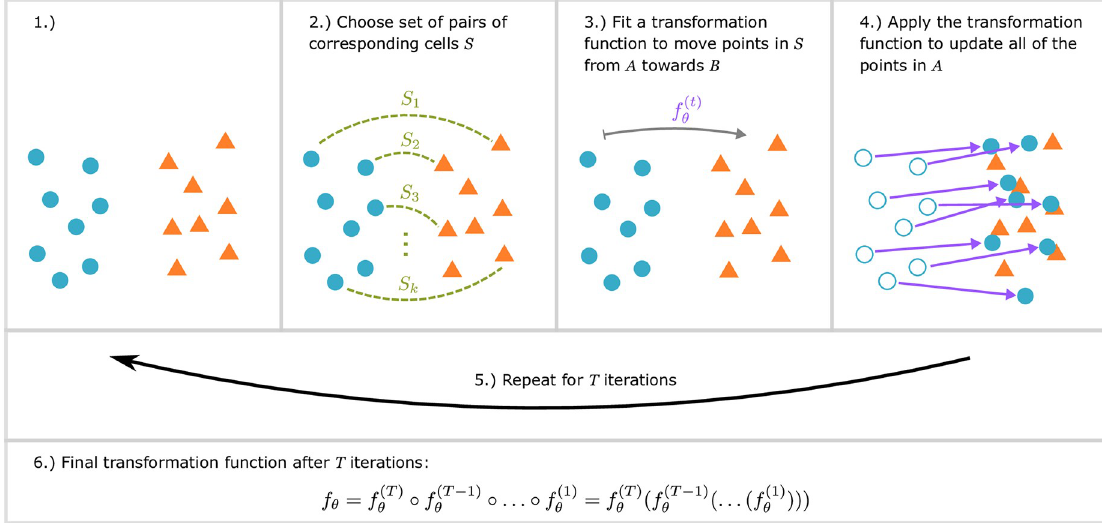
Fig 1. Summary of steps in iterative point set registration for scRNA-seq data. Each cell in an scRNA-seq dataset can be viewed as a point in high dimensional space. 1) We start with two unaligned batches (sources, blue and targets, orange). 2) A matching algorithm (e.g. picking the closest corresponding point, or using mutual nearest neighbors) is used to pair source cells from A with a corresponding target cell in B . The number of source and/or target cells matched can vary for different matching strategies. 3) Based on the selected pairs, a global transformation function is learned so that source cells in A become closer to their paired cell in B . 4) The learned transformation is next applied to all points in A . 5) This process (steps 2–4) is repeated, iteratively aligning set A onto B until the mean distance between the assigned pairs of cells no longer improves. 6) The final global transformation function is the composition of the functions learned in each iteration at step 3.